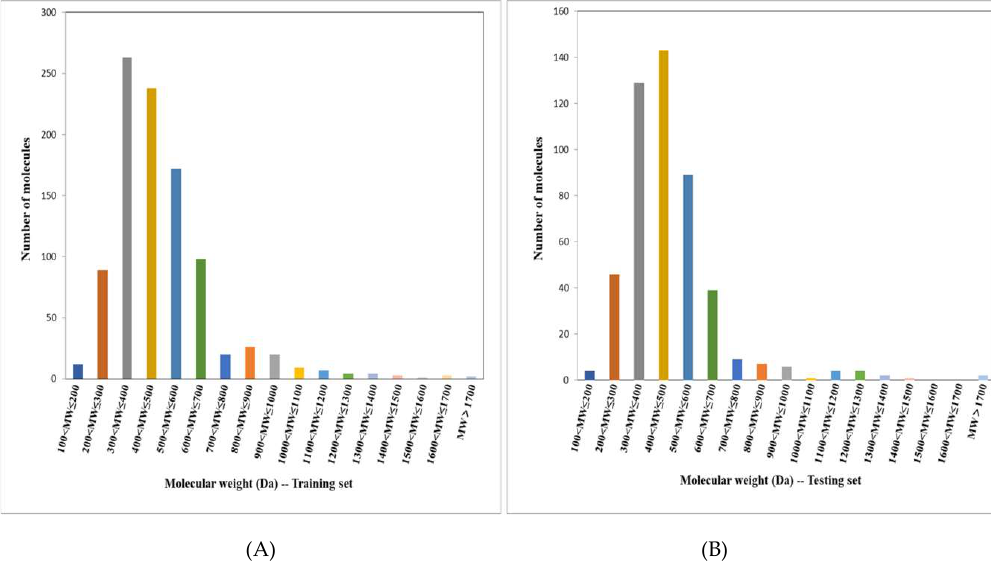
Figure 9. The molecular weight distributions of compounds ( A ) in the training set (971 compounds), and ( B ) in the testing set (486 compounds).